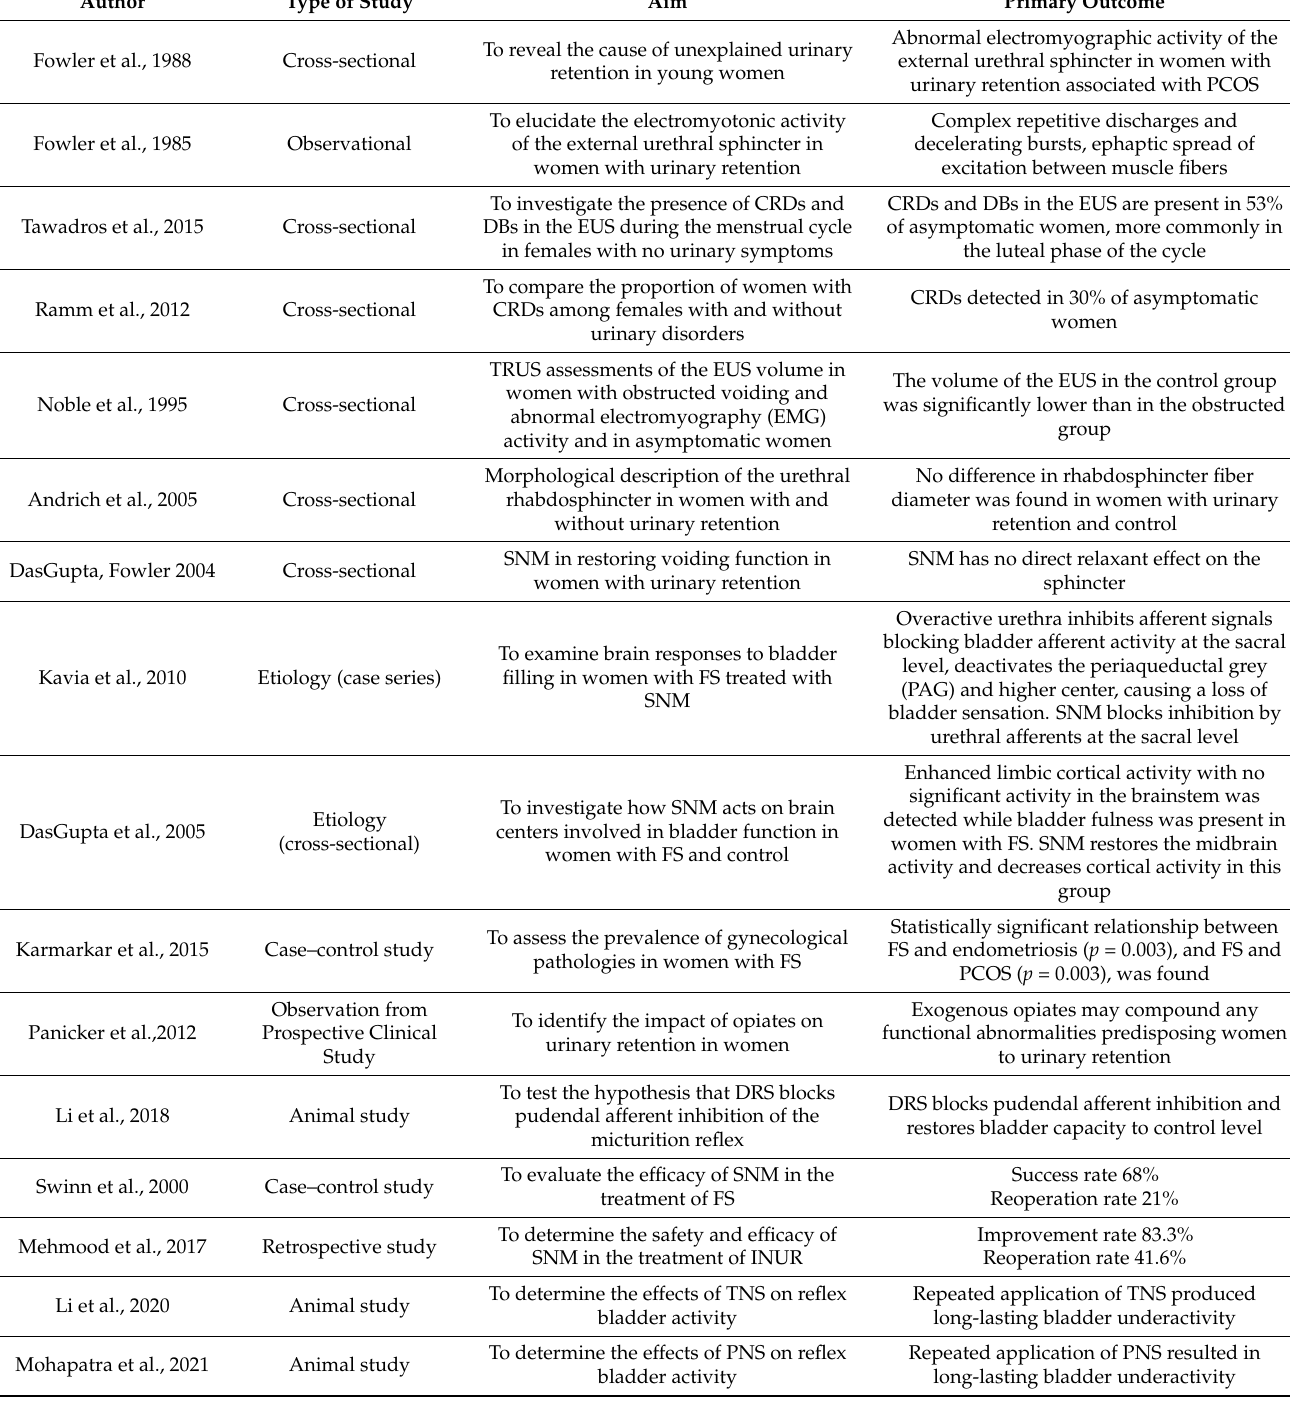
Table 1. Original studies on sacral neuromodulation. PCOS—Polycystic Ovary Syndrome, CRDs—complex repetitive discharges, DBs—decelerating bursts, EUS—external urethral sphincter, TRUS—transrectal ultrasonography, SNM—sacral neuromodulation, FS—Fowler’s syndrome, PAG—periaqueductal grey, DRS—dorsal root stimulation, INUR—idiopathic nonobstructive urinary retention, TNS—tibial nerve stimulation, PNS—pudendal nerve